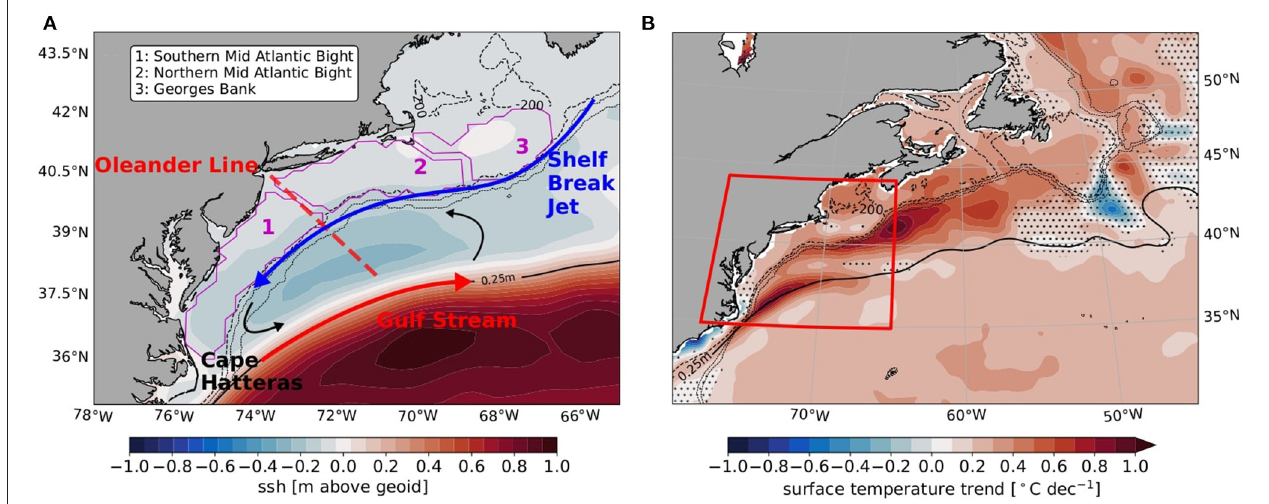
FIGURE 1 | Map of the study region and observed surface temperature trends; (A) Magenta contours indicate shelf ecoboxes defined by Chen et al. (2020); red dashed line indicates mean track of the CMV Oleander; shaded is the mean absolute dynamic topography from CMEMS altimeter data for 1993 to 2019 with the 0.25m level indicated by the black line; red arrow indicates the Gulf Stream, blue the Shelfbreak Jet and black the recirculation gyre; (B) linearly regressed surface temperature trends from NOAA OISST annual values for 1982–2019; stippling indicates non-significant values below the 99% level; red box marks region of (A) ; 0.25m absolute dynamic topography contour is shown for reference; dashed black lines in (A,B) show isobaths of 200, 1,000, 2,000, and 4,000 m